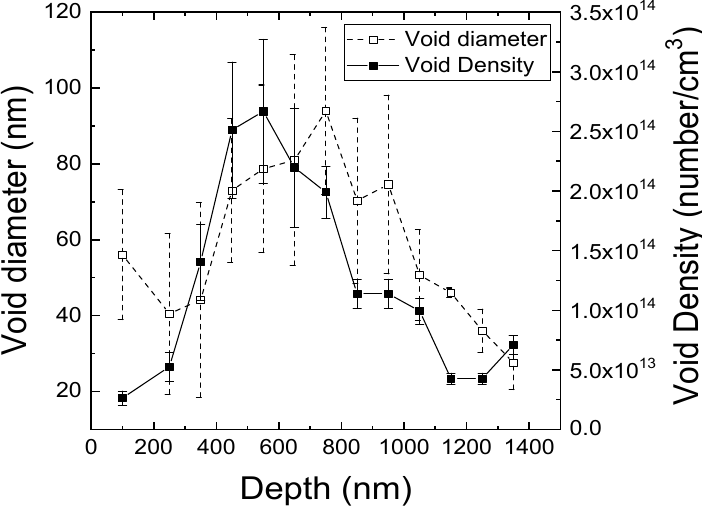
Figure 3. TEM micrograph of irradiated Fe in the vicinity of a trench which starts at about ~1.7 µ m beneath the surface.